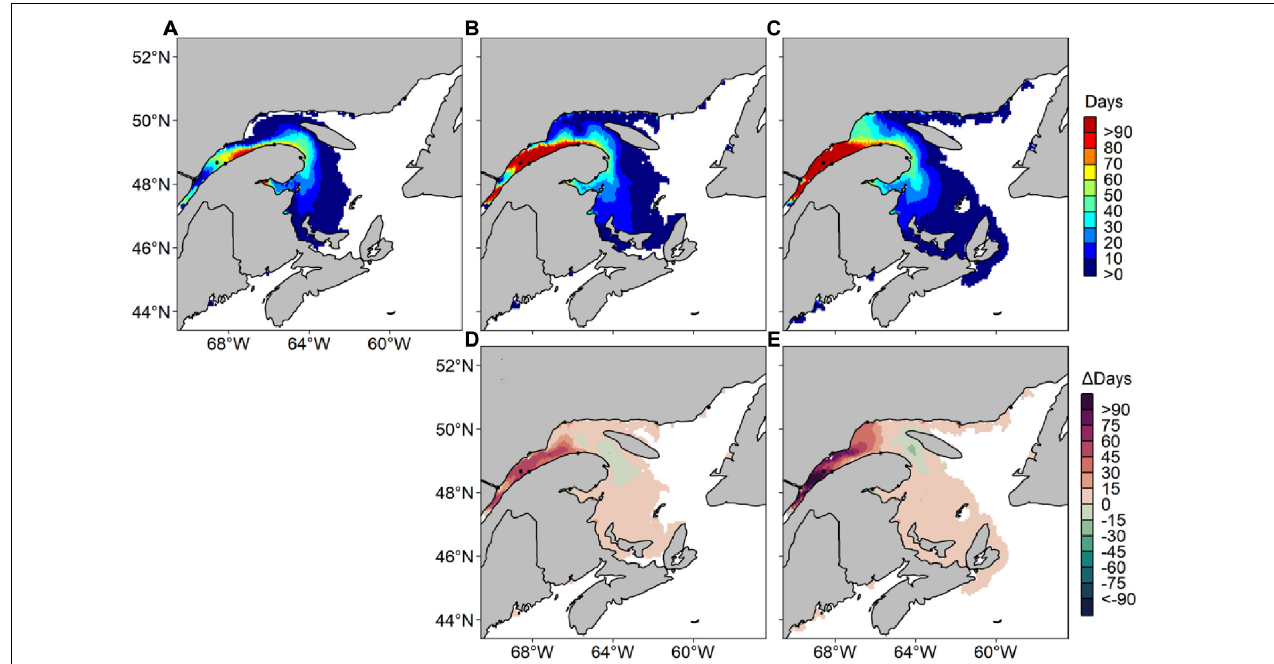
FIGURE 9 | Average number of risk days with Alexandrium catenella ≥ 1000 cells L − 1 from May through October along Canada’s East coast under CanESM2 RCP 8.5 for (A) 1999–2008, (B) 2050–2059, (C) 2090–2099 and difference in average number of risk days between (D) 1999–2008 and 2050–2059 and (E) 1999–2008 and